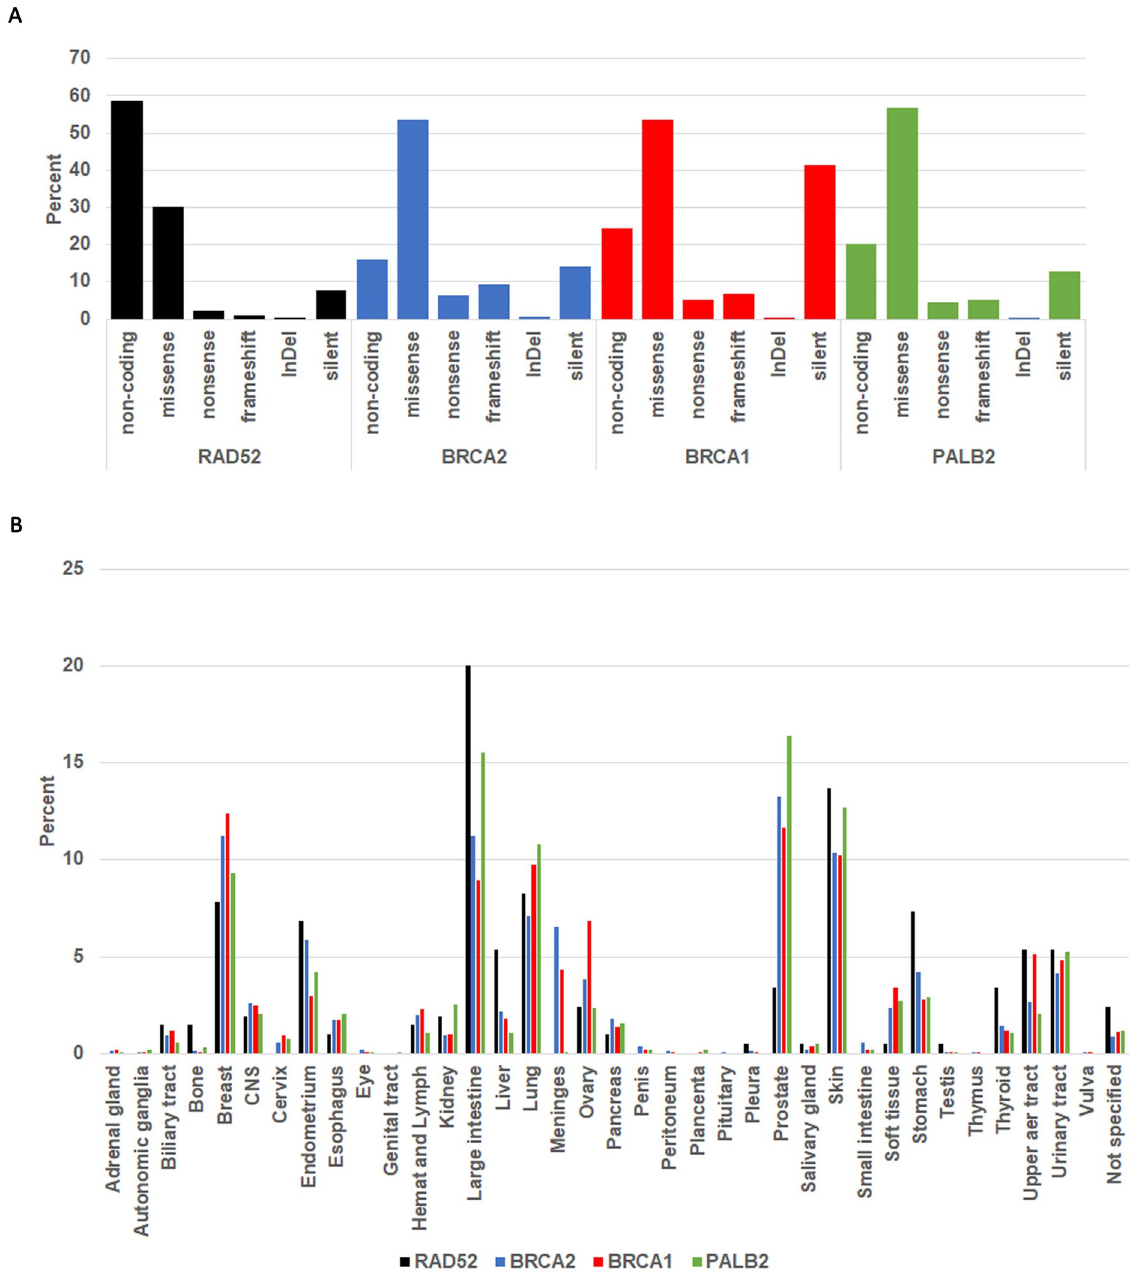
Fig 1. Distribution of RAD52, BRCA2, BRCA1 and PALB2 mutations in cancer cells. A . Distribution by type of mutation. The COSMIC mutations were partitioned into non-coding (5’ UTR, 3’UTR and intronic) and coding (translated). The coding mutations were further partitioned into missense, non-sense, frameshift, InDels and silent. All frameshift mutations introduce a stop codon and are therefore truncations. B . The distribution of all coding RAD52, BRCA2, BRCA1 and PALB2 among the various cancers reported on COSMIC. The large intestine, breast, prostate and skin are the most represented